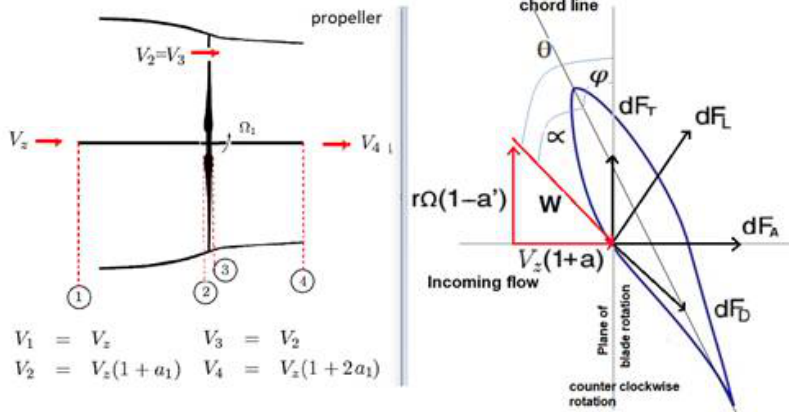
Figure 3. Axial streamtube for a solo propeller (left) and velocity triangle with rotation direction from forward-looking aft.